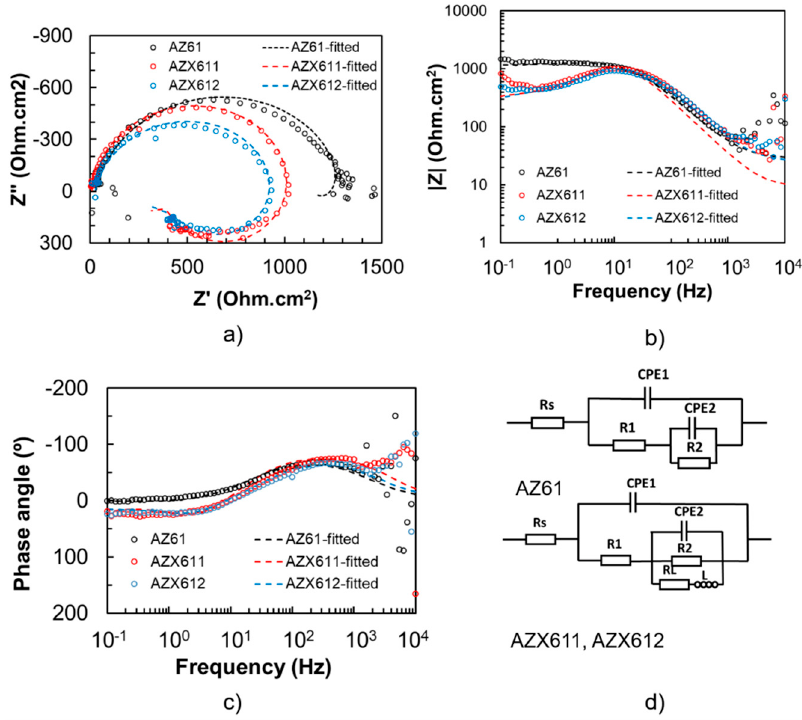
Figure 7. Electrochemical impedance spectra of uncoated specimens of AZ61, AZX611, and AZX612 specimens: ( a ) Nyquist plots, ( b ) bode plots, and ( c ) phase plots, and ( d ) the equivalent circuit.